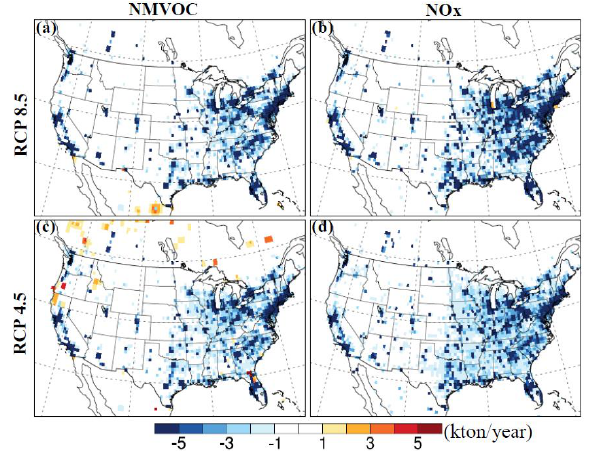
Fig. 3. Differences of NMVOCs and NO x between 2005 and 2060 (2060–2005) under RCP 4.5 and RCP 8.5.